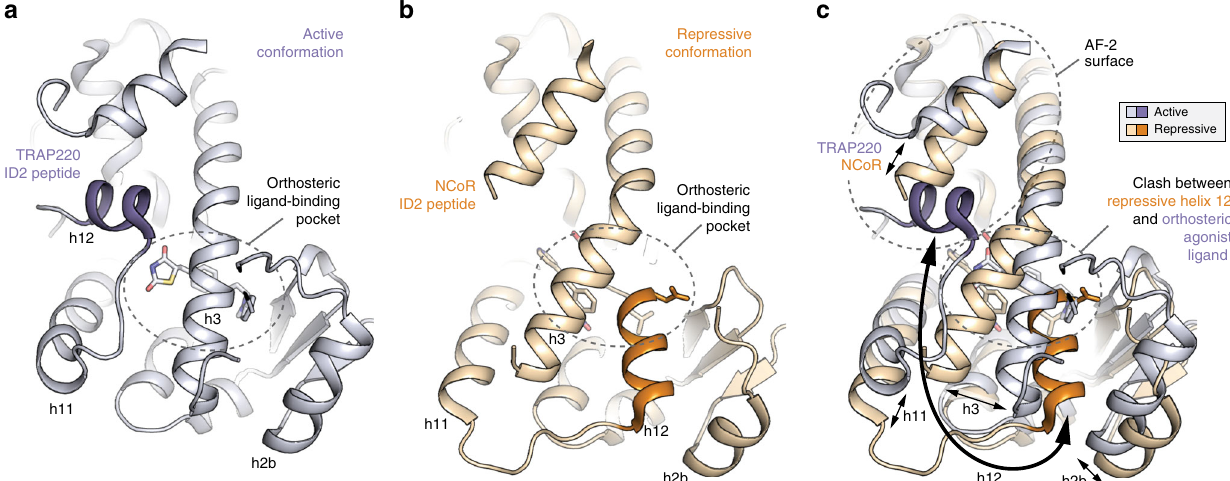
Fig. 3 Structural changes between the repressive and active PPAR γ LBD conformations. a , b Helical structural elements that show notable conformational changes in the crystal structures of a PPAR γ LBD bound to rosiglitazone and TRAP220 ID2 peptide (PDB 6ONJ) in the active conformation and b PPAR γ LBD bound to T0070907 and NCoR ID2 peptide (PDB 6ONI) in the repressive conformation. c Structural overlay of the active and repressive conformation PPAR γ LBD crystal structures with arrows depicting the movement of the helical structural elements.